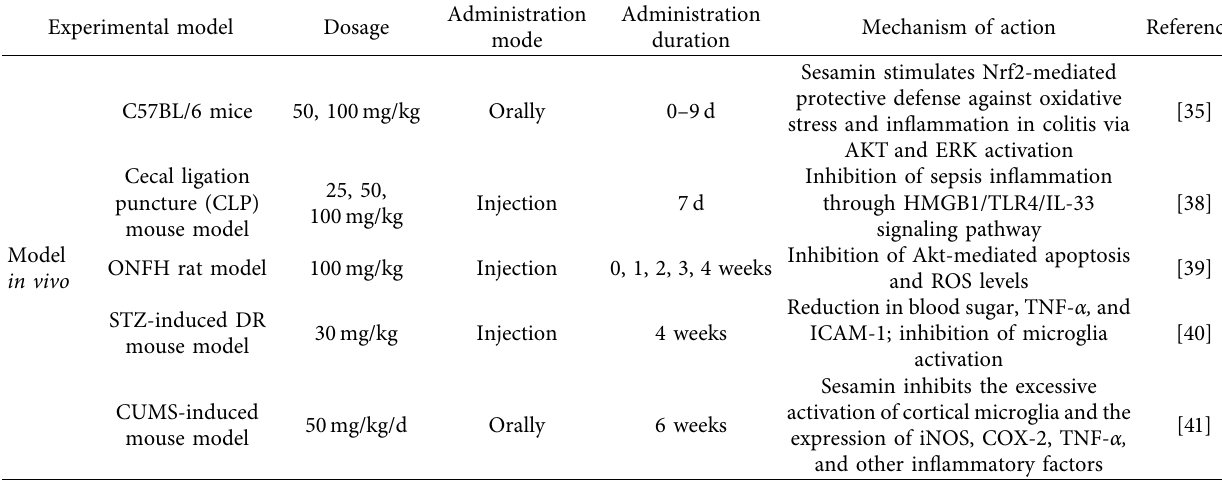
Table 2: Anti-inflammatory activity of